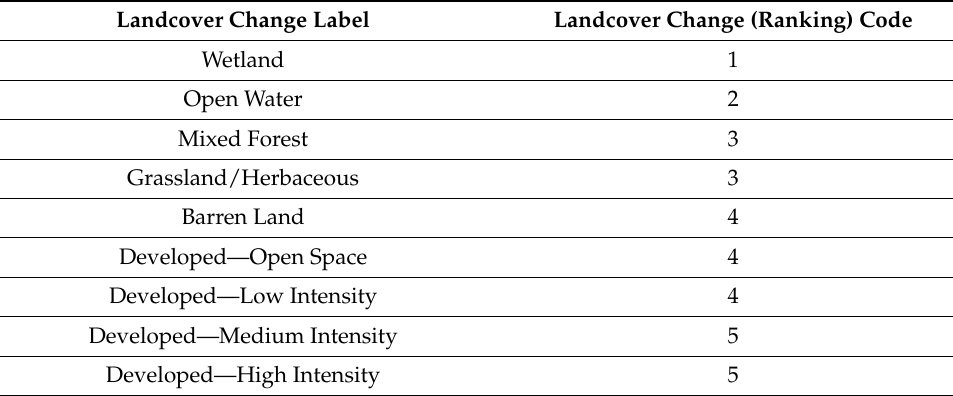
Table 2. Chicago landcover change ranking